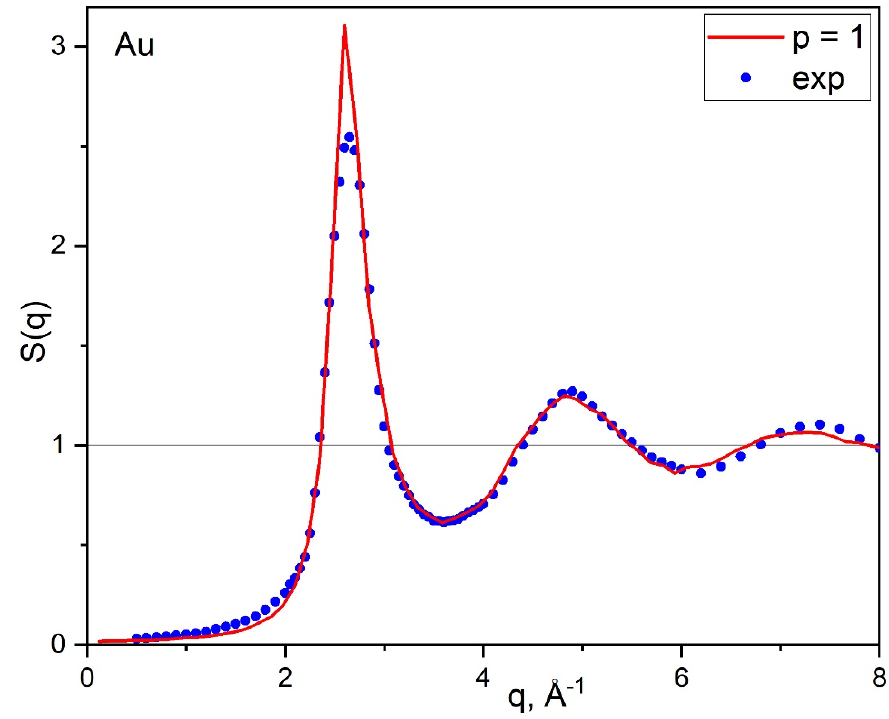
1 = p in comparison with experiment